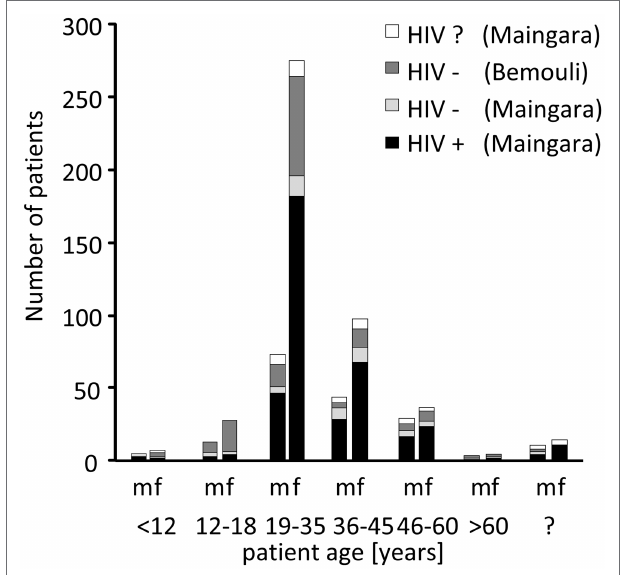
FIGURE 2 | Distribution of the patients according to age, gender, and HIV status. m, male; f, female; and ?,